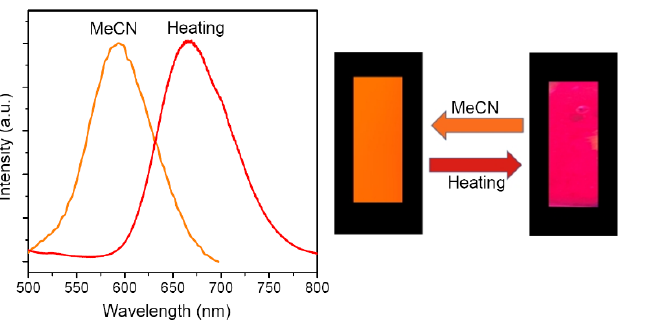
Figure 5. Emission spectra (left, Ex = 400 nm) and photos (right, under 365 nm UV light) of 1a /PMMA film in MeCN vapor and heating to 100 °C.